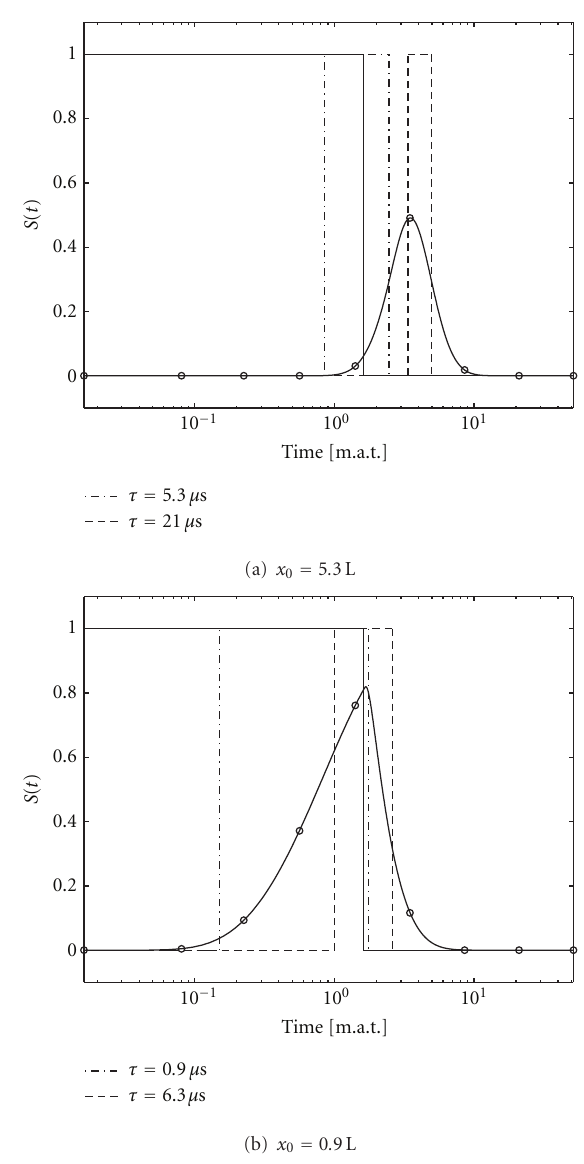
Figure 8: Time behavior of the sources according to the modifi- cations proposed. Solid: original case; dash-dotted: modification 1; dashed: modification 2; circles: modification